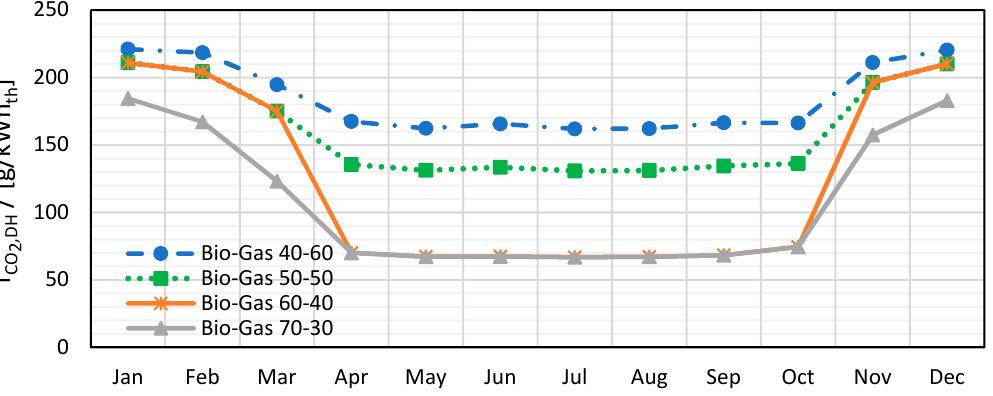
Figure 11. CO 2 conversion factors for four generic DH systems with different shares of biomass/waste heat and natural gas (our own calculations based on [13]).